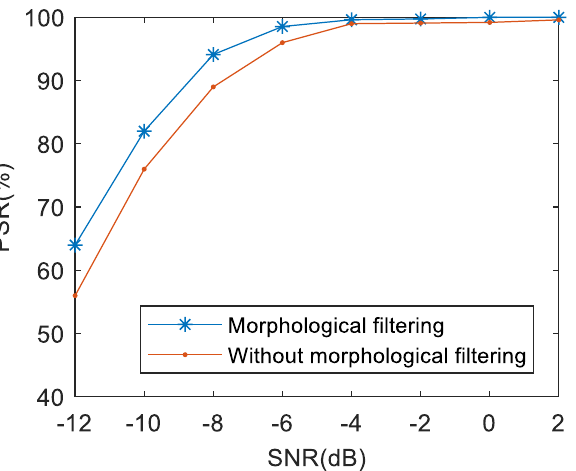
Figure 12. The effects of the morphologic filtering on the PSR of the proposed approach.